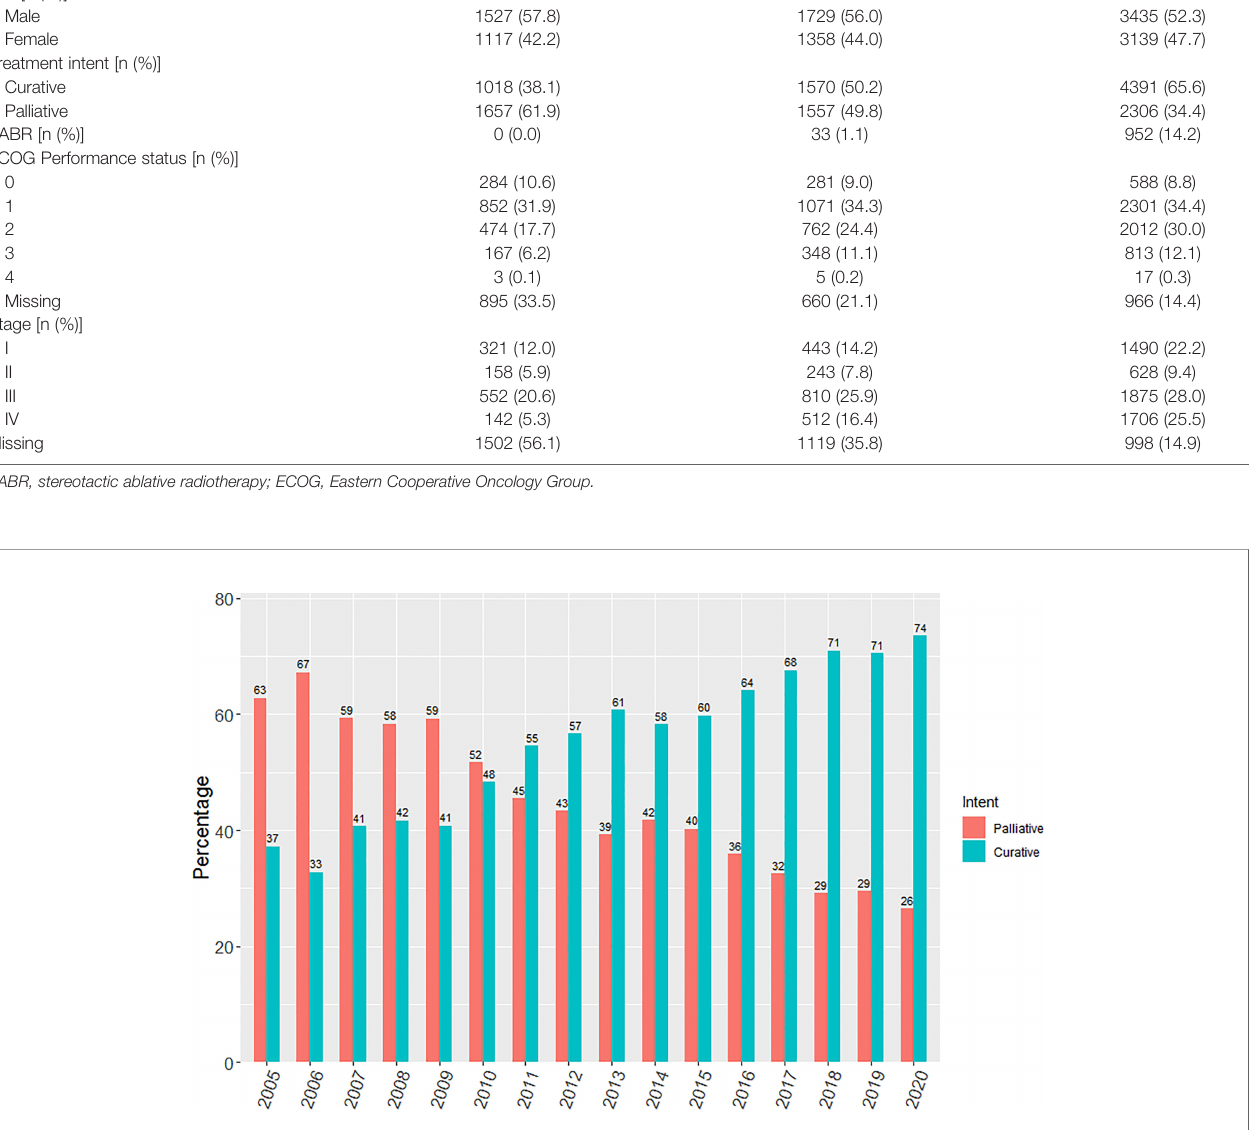
FIGURE 1 | Yearly percentage of patients treated with curative versus palliative intent radiotherapy from 2005 to